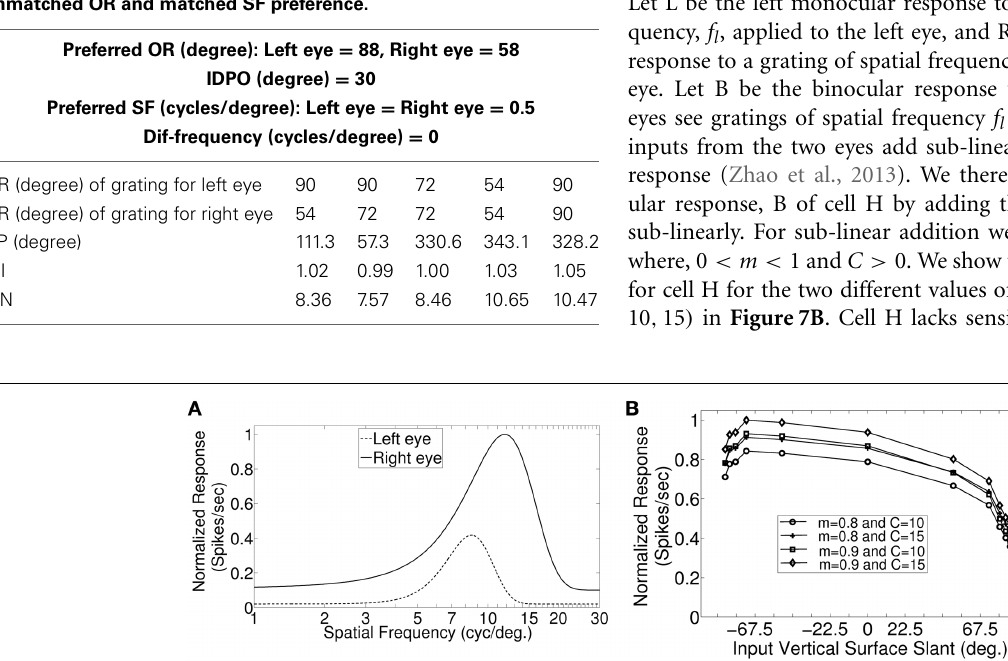
Frontiers in Systems